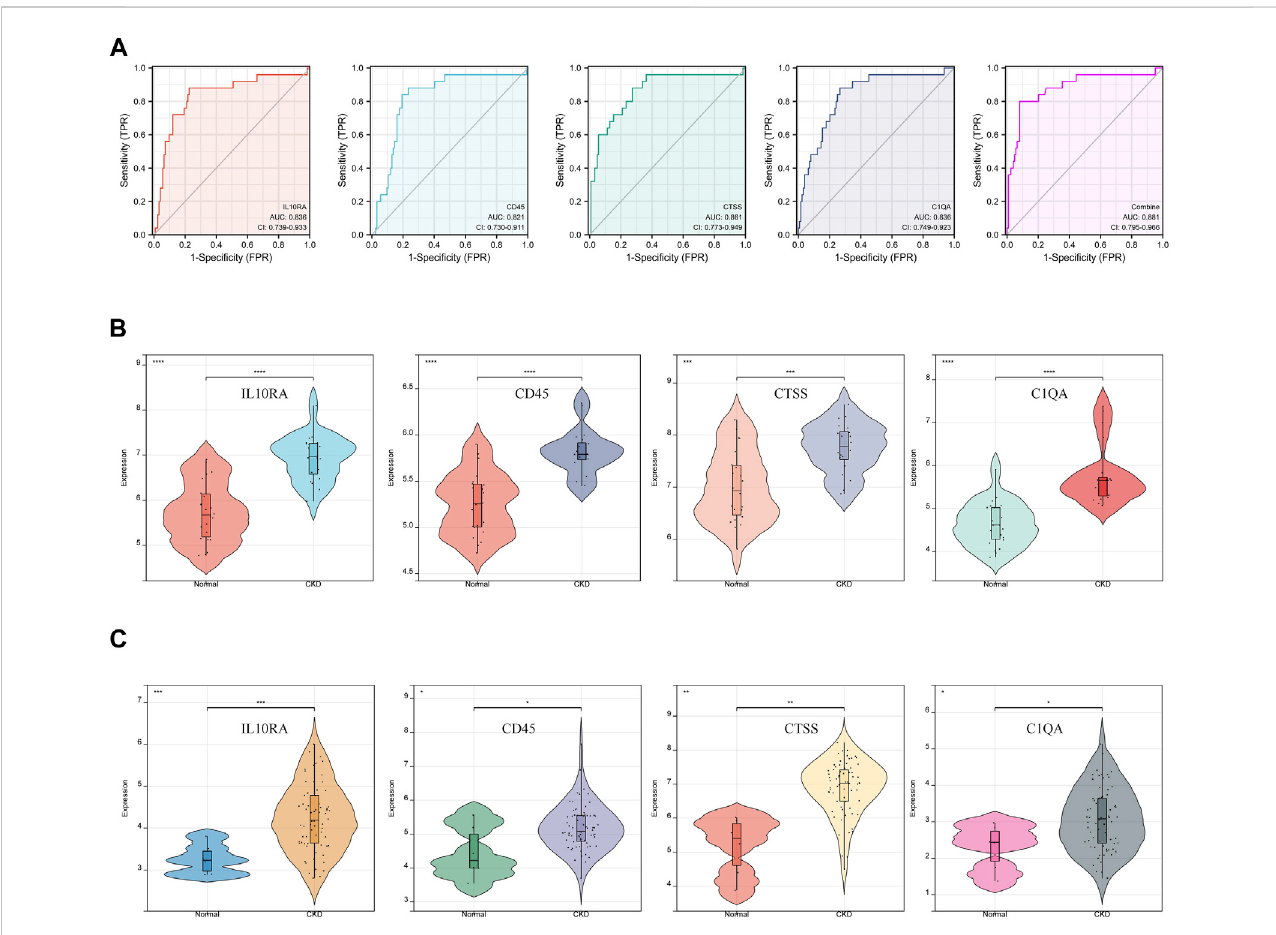
FIGURE 6 Diagnostic effectiveness and dataset validation of the hub genes for CKD. (A) ROC curves to assess the diagnostic ef fi cacy of hub genes. (B) Data validation of hub genes by GSE93798. (C) Data validation of hub genes by GSE104066.